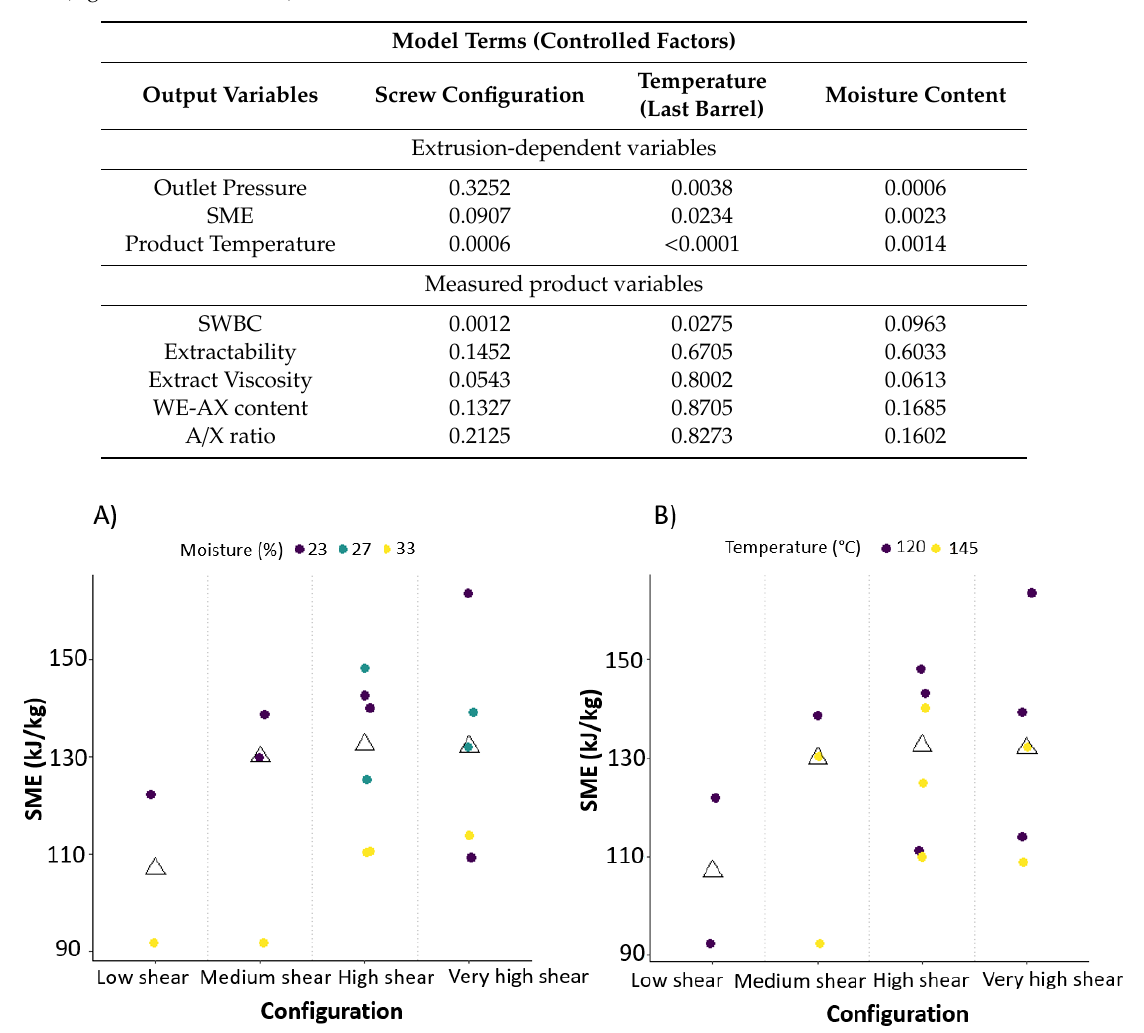
Table 2. p -value table of the linear model describing the effect of the model terms (screw configuration, last-barrel set temperature and moisture content) on the extrusion dependent variables (outlet pressure, specific mechanical energy (SME), product temperature at the extruder outlet) and the measured product variables (strong water binding capacity (SWBC), extractability, extract viscosity, water-extractable arabinoxylan (WE-AX) content and arabinose to xylose (A/X) ratio). The model was built for each output variables (Y) using the following equation: Y = α + β 1 × Configuration + β 2 × Temperature + β 3 × Moisture. The output variable is determined by the model terms if p -value is smaller than 0.05 (significance threshold).